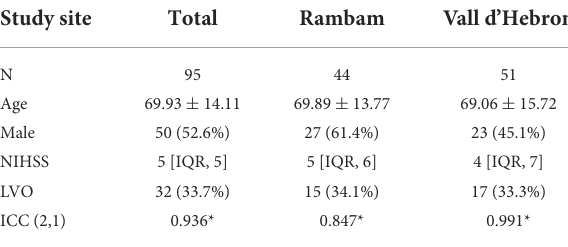
TABLE 1 Patient characteristics and intraclass correlation coefficient (ICC) of total National Institute of Health Stroke Scale